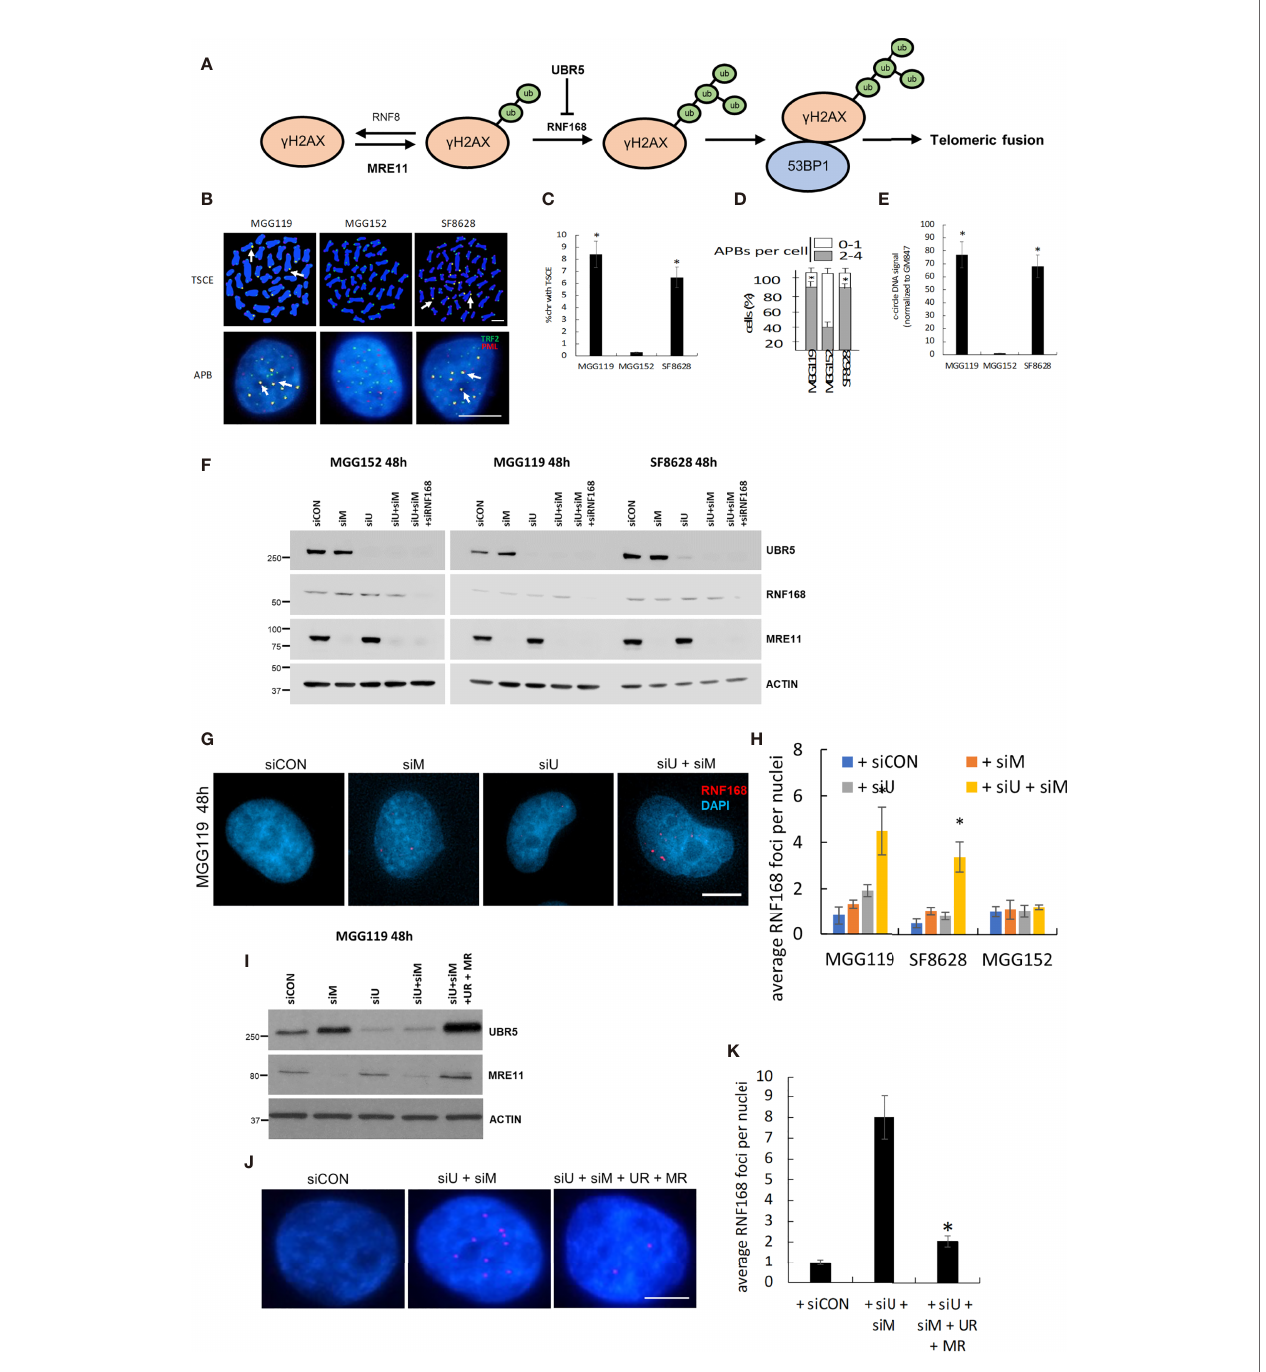
FIGURE 1 | (A) Schematic of the basis for MRE11 and UBR5 mediated chromosome fusion in ALT-dependent cells. (B) Representative images and quantitation of T-SCE (CO-FISH, C ), APBs (D) , and c-circle DNA (E) in MGG119, MGG152 and SF8628 cells. (F) Western blot veri fi cation of MRE11, UBR5, RNF168, and b -actin protein levels in MGG119, MGG152 and SF8628 cells 48hr after transfection with scrambled siRNA or pooled target siRNAs. (G) Representative images of MGG119 incubated with the indicated siRNAs for 48 hours and then immunostained with RNF168 antibody (red). (H) The average RNF168 foci number in each treatment of MGG119, MGG152 and SF8628 cells were counted, a minimum of 100 nuclei were assessed. (I) Western blot veri fi cation of MRE11, UBR5 and b -actin protein levels in MGG119 cells 48hr after transfection with scrambled siRNA, siRNAs targeting MRE11 and UBR5, or siRNAs targeting MRE11 and UBR5 followed by transfection with constructs encoding siRNA-resistant MRE11(MR) and UBR5(UR). (J, K) Representative image (J) and quantitation (K) of MGG119 incubated with the indicated siRNAs and siRNA-resistant MRE11(MR) and UBR5(UR) for 48 hours and then immunostained with RNF168 antibody (red). Mean ± SD of 3 independent experiments are shown. *P <